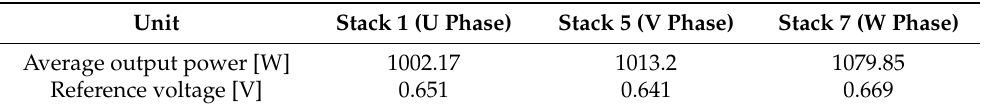
Table 3. Comparison of RMS value of average output power and reference voltage when fourth stack fails in applying the proposed neutral-point voltage-shifting control.